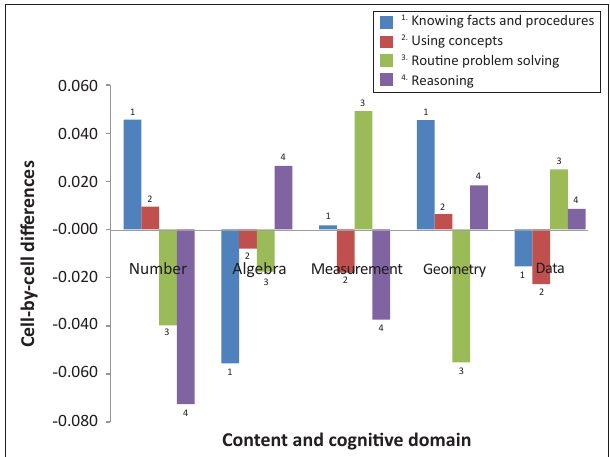
FIGURE 3 : Discrepancies between RNCS assessment standards and TIMSS target